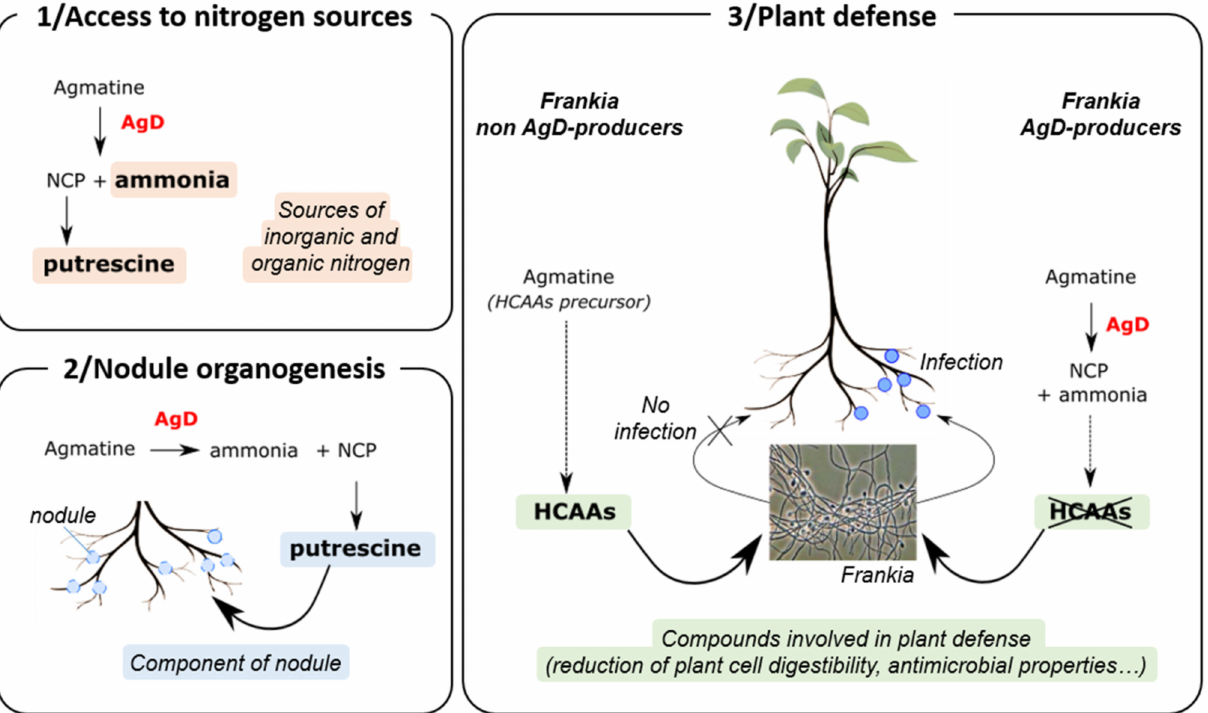
Figure 2. Proposed roles for agmatine deiminase (AgD) in the relationship Frankia / Alnus regarding: 1. Access to nitrogen: AgD produced by Frankia could be used in order to degrade agmatine found in the plant. The enzyme could thus allow Frankia to access putrescine (via the conversion of NCP into putrescine) and ammonia as sources of nitrogen, 2. Nodule organogenesis: putrescine obtained from NCP after degradation of agmatine by AgD could be used in nodule development, as putrescine is one of the main polyamine in roots and nodules of actinorhizal and 3. Plant defense: Hydroxycinnamic acid amides (HCAAs) produced by Alnus from agmatine are secondary metabolites involved in the defense of plants against pathogens. Production of AgD by Frankia AgD producers leads to the degradation of agmatine into N-carbomoyl-putrescine and ammonium and puts a stop to